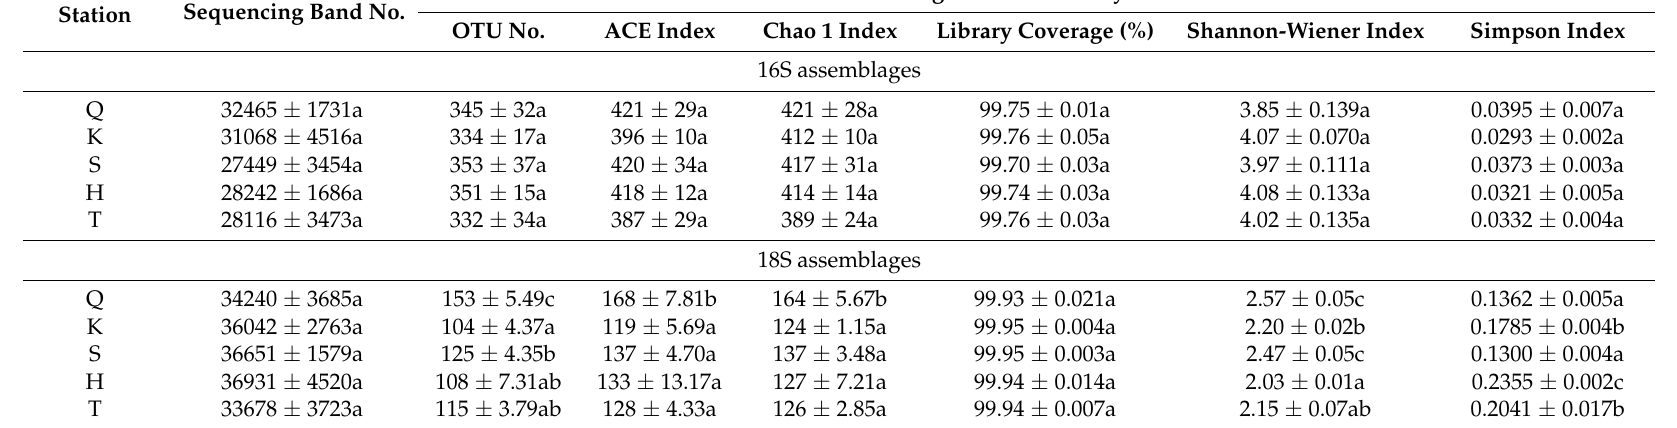
Table 2. Estimation of molecular diversity of 16S and 18S assemblages. Station codes represented the first letter of their names: Q: Qushou, K: Kuxin, S: Songgan, H: Heijizuo, T: